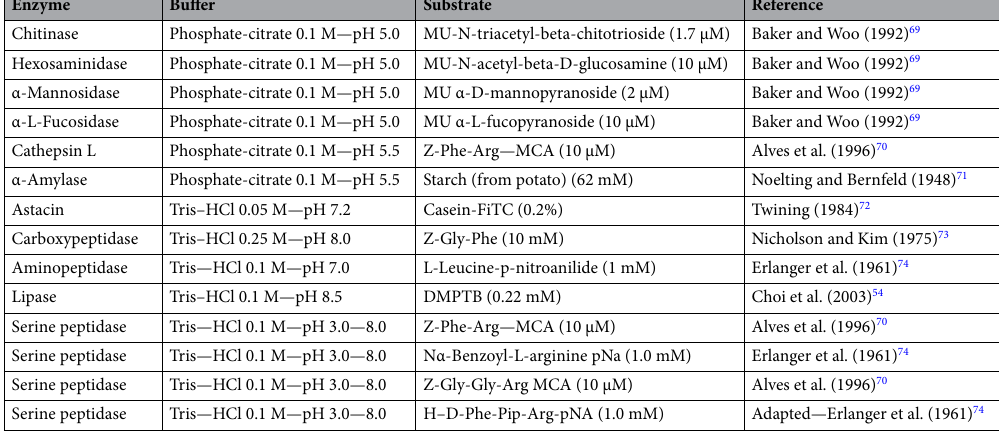
Table 1. Enzymatic assay conditions*. *Assay pHs conditions, substrates, references, and their final concentrations in assays, used to measure the enzyme’s activities from 11 different enzymes found in Uloborus sp . midgut. MU = 4-Methylumbeliferyl; Z = carbobenzoxy; MCA = 7-amido-4-methylcoumarin hydrochloride; DMPTB: 2,3-Dimercapto-1-propanol tributyrate; pNa;p-nitroanilide.